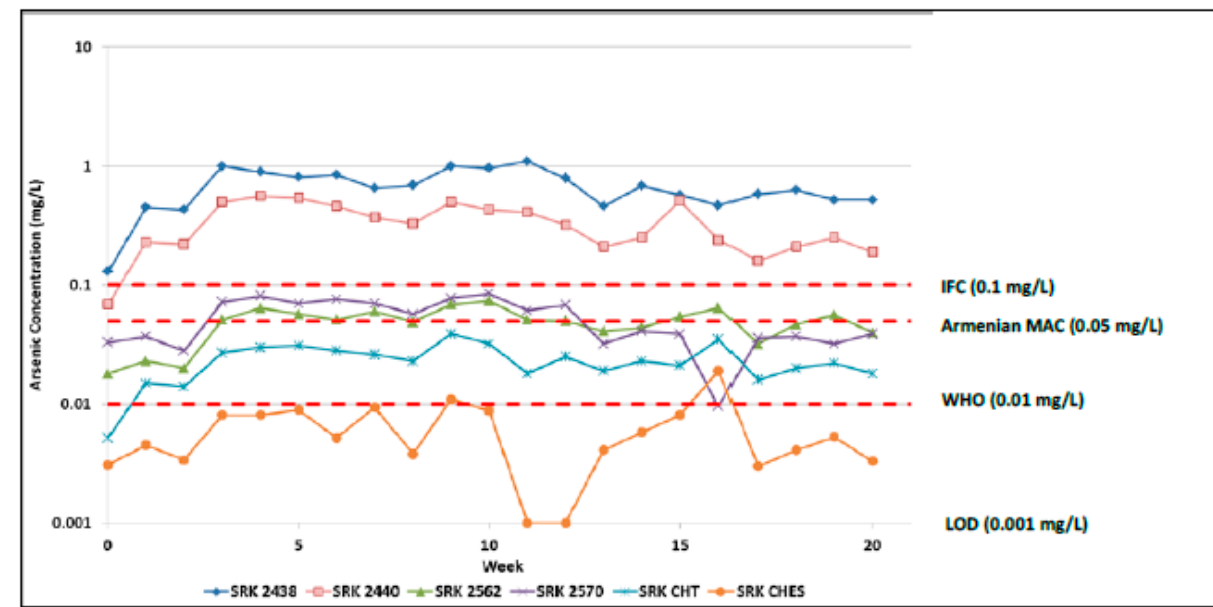
Figure 13. Time series plot of arsenic against weekly humidity cell cycle compared to IFC (top), WHO (middle) and Armenian MAC (bottom) guidelines, LOD (limit of detection).